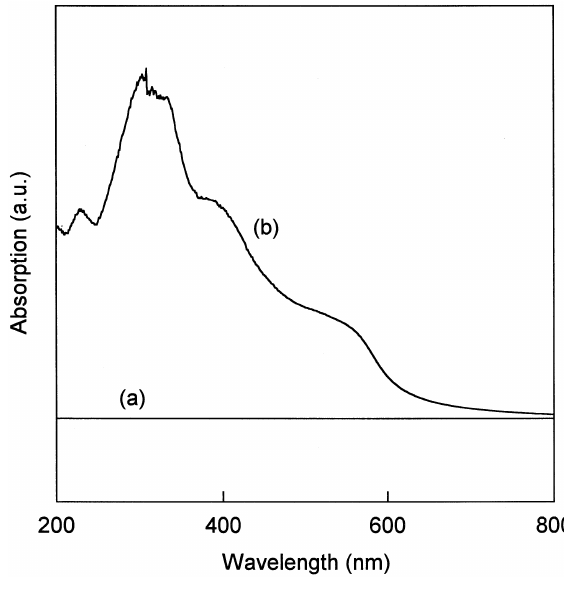
Figure 5. Visible-ultraviolet/diffuse reflectance spectra of different samples obtained in different steps in Scheme 2: ( a ) AlPO support and ( b ) 4-hydroxybenzaldehyde on support 4 after microwave heating (step